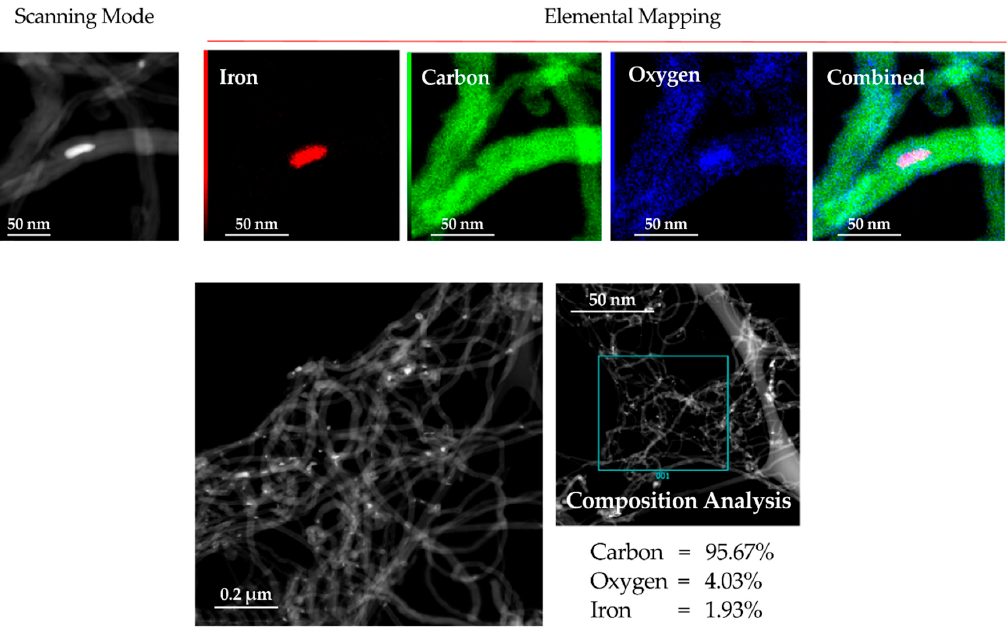
Figure 4. HR-TEM—EDX results of carbon nanotubes used for MWCNT / epoxy composite.